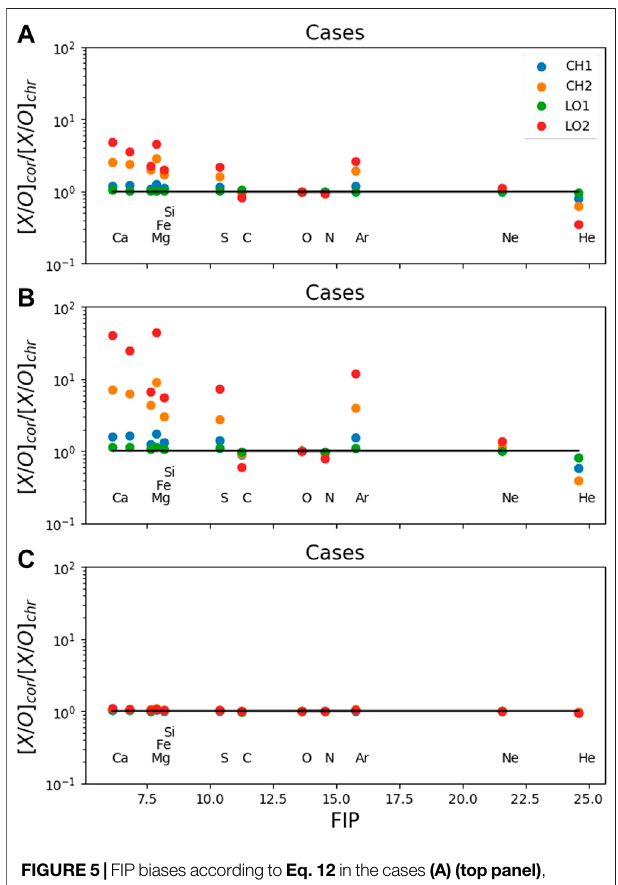
FIGURE5| FIP biases accordingto Eq. 12 inthe cases (A)(toppanel) , (B) (middle panel) , and (C) (bottom panel) for usual minor ions. The integration is made between z chr (cid:1) 700 km and z cor (cid:1) 7000 km above the solarsurface.Theturbulentvelocityentering Eq.12 v T (cid:1) 15